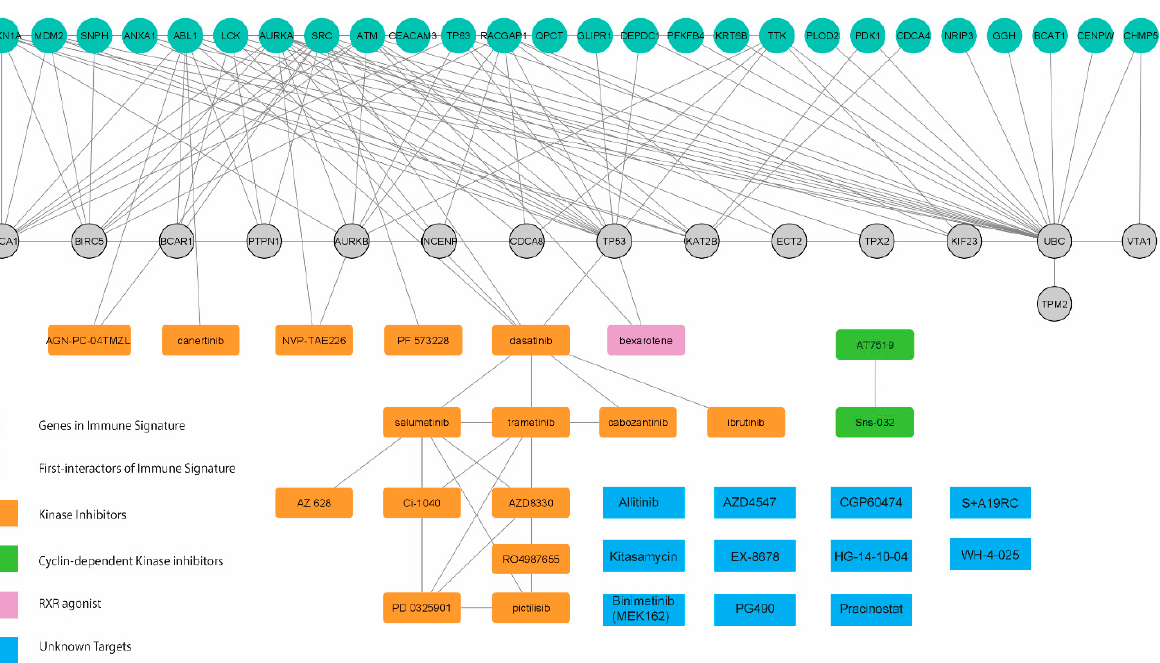
Figure 5. The integrative drug–gene network analysis. Interactions among 29 commonly connected perturbations and 26 mortality-associated immune-related genes were established depending on STITCH database using Cytoscape v.3.8 and stringApps v.1.7.0 plugin.